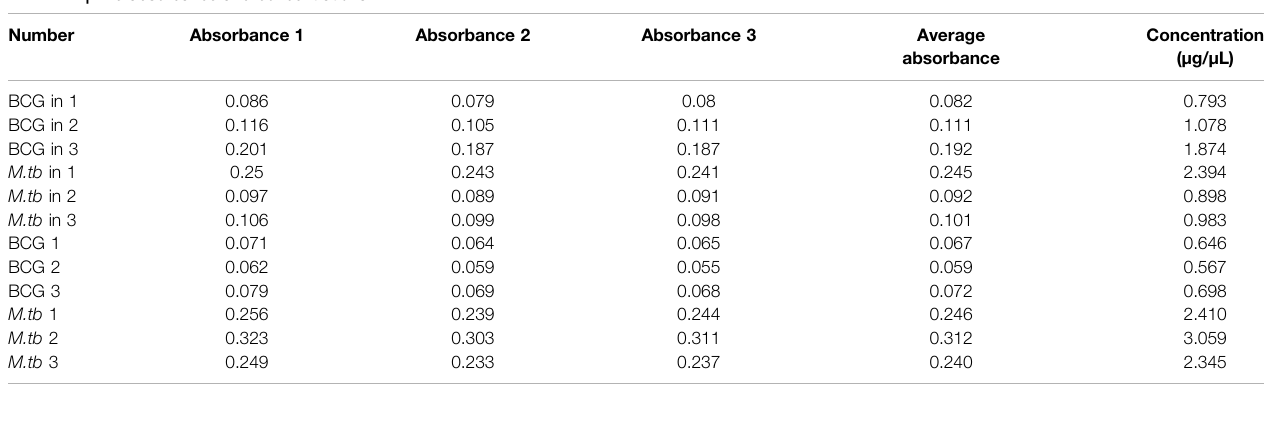
TABLE 1 | The absorbance and concentrations.